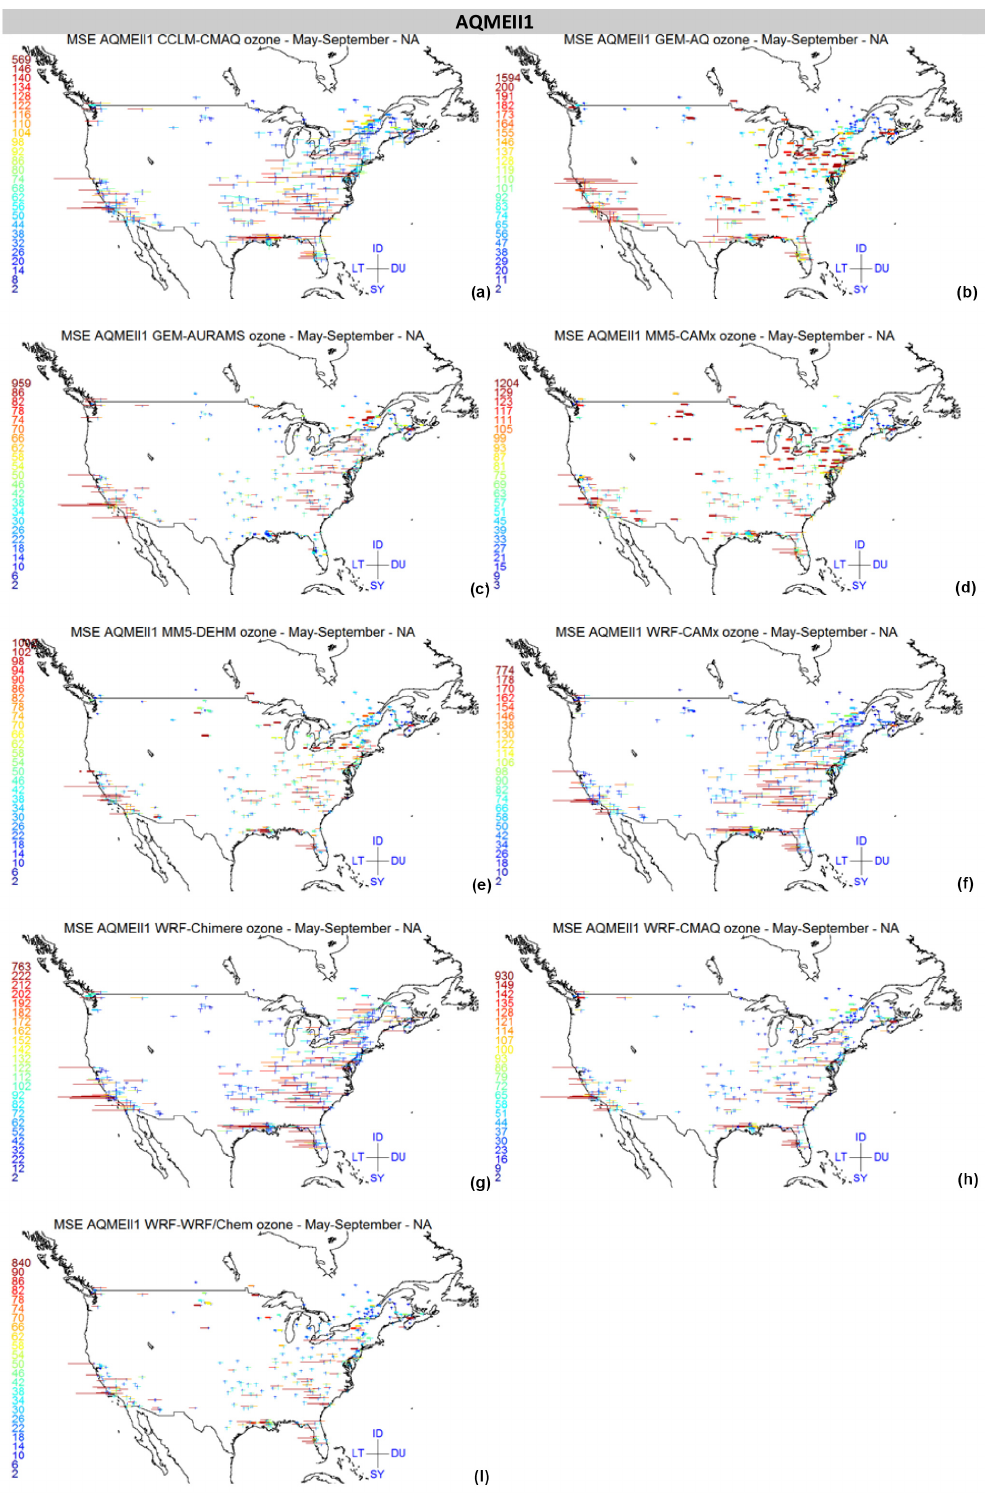
Figure 4. As in Fig. 3, but for the NA models of AQMEII1.